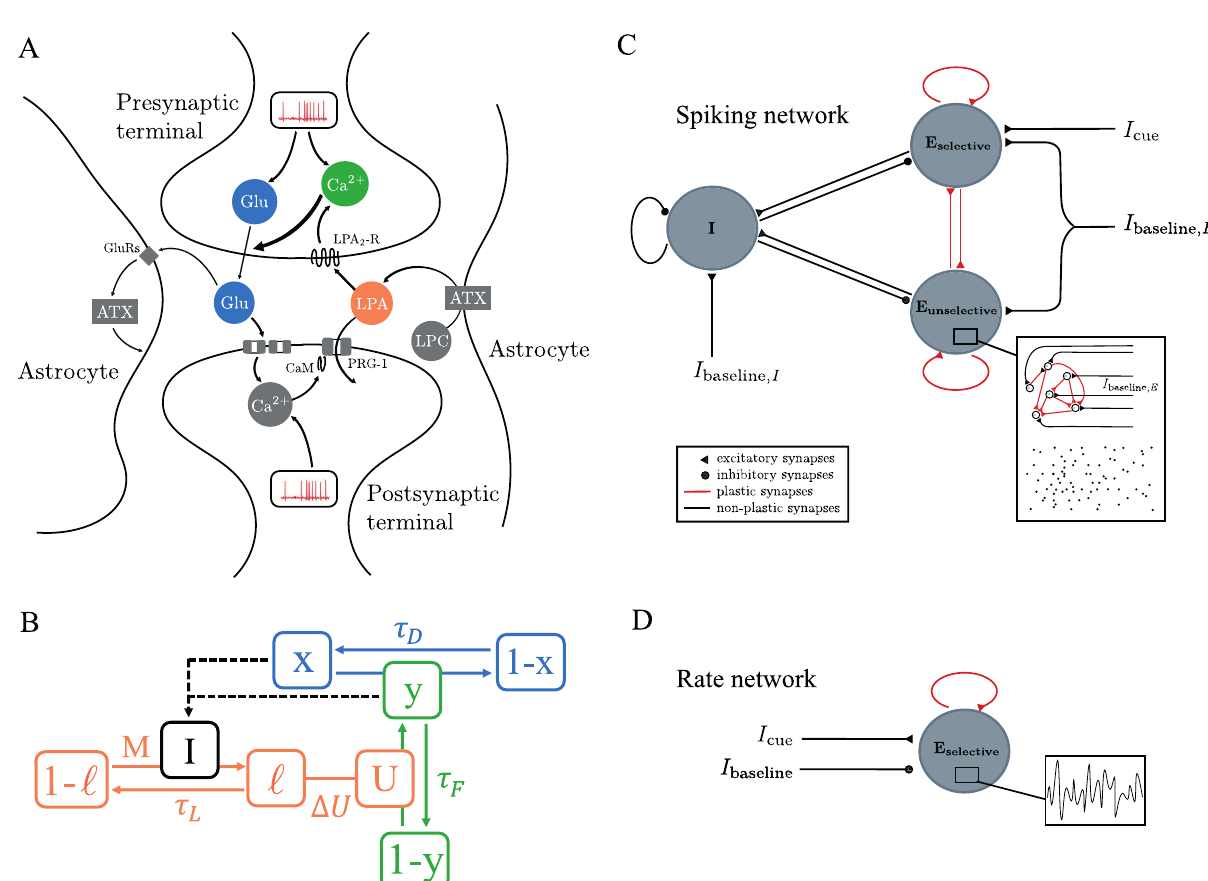
Fig 1. Synaptic working memory (WM) with astrocytic signaling: Synapse and network model. A Sketch of the transmission dynamics at tripartite glutamatergic synapses, as determined by the components of presynaptic STP, and its modulation by the astrocytic enzyme ATX [43] and the postsynaptic protein PRG1 [42] via lysophosphatidic acid (LPA). Presynaptic STP influences synaptic transmission via glutamate availability (blue) and calcium-binding (green) at the presynaptic terminal. The astrocytic and postsynaptic components modulate presynaptic calcium-binding rates by increasing the concentration of LPA in the synaptic cleft, which allows more LPA in the synaptic cleft (orange) to bind to the presynaptic LPA2 receptors. Postsynaptic calcium increases LPA concentrations in the cleft by inhibiting the postsynaptic protein PRG1 (via CaM) that usually takes up newly synthesized LPA from the cleft. Astrocytic, ATX-mediated synthesis of LPA is amplified in a activity-dependent way, since some of the synaptically transmitted glutamate binds to astrocytic receptors that increase ATX activity. Implications of elevated calcium-binding due to LPA signaling for paired-pulse-ratio are shown in Fig B in S1 Text. B Sketch of the synapse model that captures the transmission dynamics shown in (A). The dynamics of the synaptic variables x (neurotransmitter availability), y (presynaptic calcium binding), and ℓ (presynaptic LPA binding) are determined by the STP parameters U , τ D and τ F and the additional astrocytic signaling parameters Δ U (maximal LPA-mediated increase of U ), M (activity-dependent increase of ℓ ) and τ (decay timescale of ℓ ). The equations of the synapse model (Eqs 1, 2, 4 and 5) and the dynamics of each L variable are described in Models and methods. C Sketch of the spiking network model of synaptic WM (architecture as in Mongillo et al. [5]). The network consists of two excitatory populations and one global inhibitory population. Each population consists of sparsely and randomly connected LIF neurons. During the WM protocol, all neurons receive an excitatory baseline input with Gaussian white noise. When the WM cue is presented, the neurons of the excitatory selective population receive an additional external input I cue . All except excitatory-to-excitatory (E-E) connections have fixed synaptic weights. All E-E connections underlie either only STP (STP networks) or STP with astrocytic modulation by the LPA-mechanism as sketched in A and B (STP+LPA spiking network). D Sketch of the rate network model of synaptic WM. The rate network consists of one excitatory population that is described by a single population firing rate. The recurrent excitatory connections underlie either only STP or STP with astrocytic modulation (LPA-mechanism) as sketched in A and B. We refer to these networks as STP rate networks and STP+LPA rate networks, respectively. During the entire WM protocol, the excitatory population receives a constant baseline input current with Gaussian white noise. This input is inhibitory since it represents the combined effect of global inhibitory and inputs from surrounding (non-selective) excitatory populations. During the cue presentation, it receives an additional excitatory input current I cue